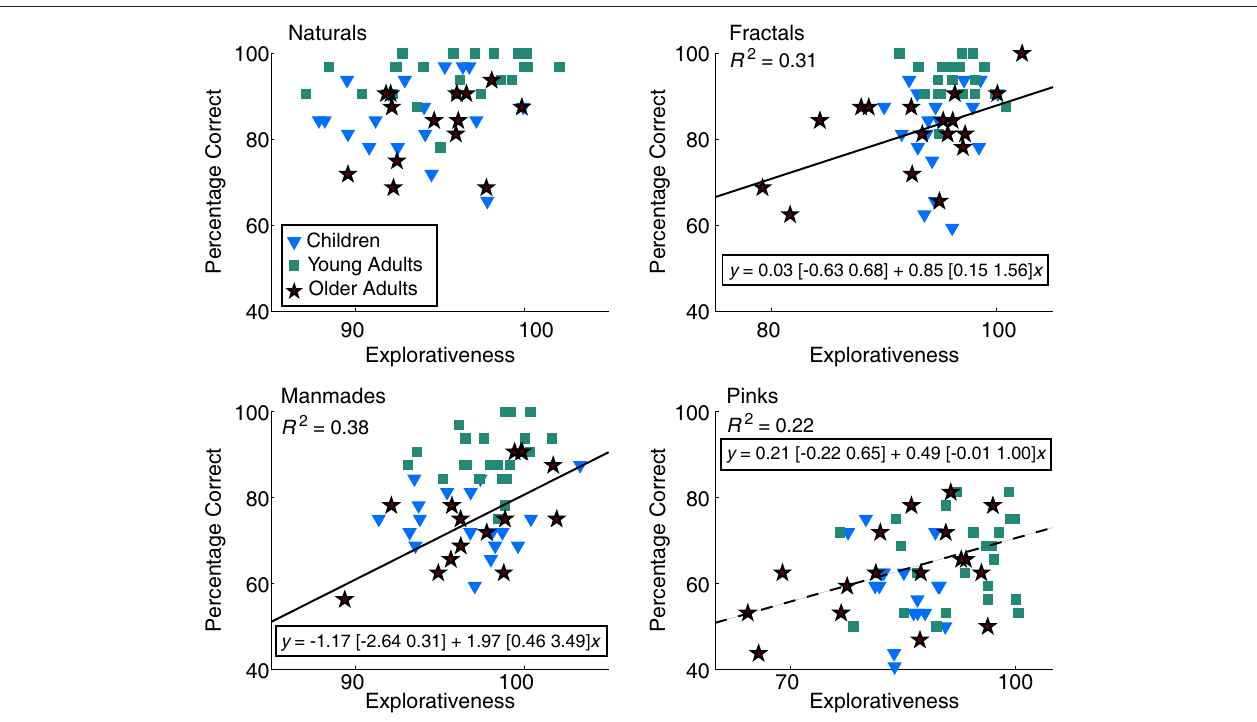
Figure 4 | Linear regression analysis of explorativeness and percentage correct. For each age group and category separately, we removed outliers (3 older adults in naturals , and 2 older adults manmades ) and computed linear regressions for subject-specific explorativeness and percentage correct values. Inside the panels, each marker corresponds to one subject and the regression line is shown with the age color code. As can be seen, in three out of four